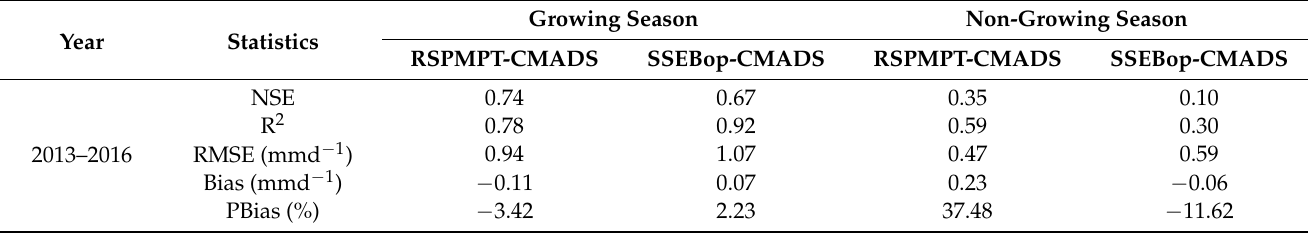
Table 5. The error statistics for the ET estimated by RSPMPT-CMADS and SSEBop-CMADS